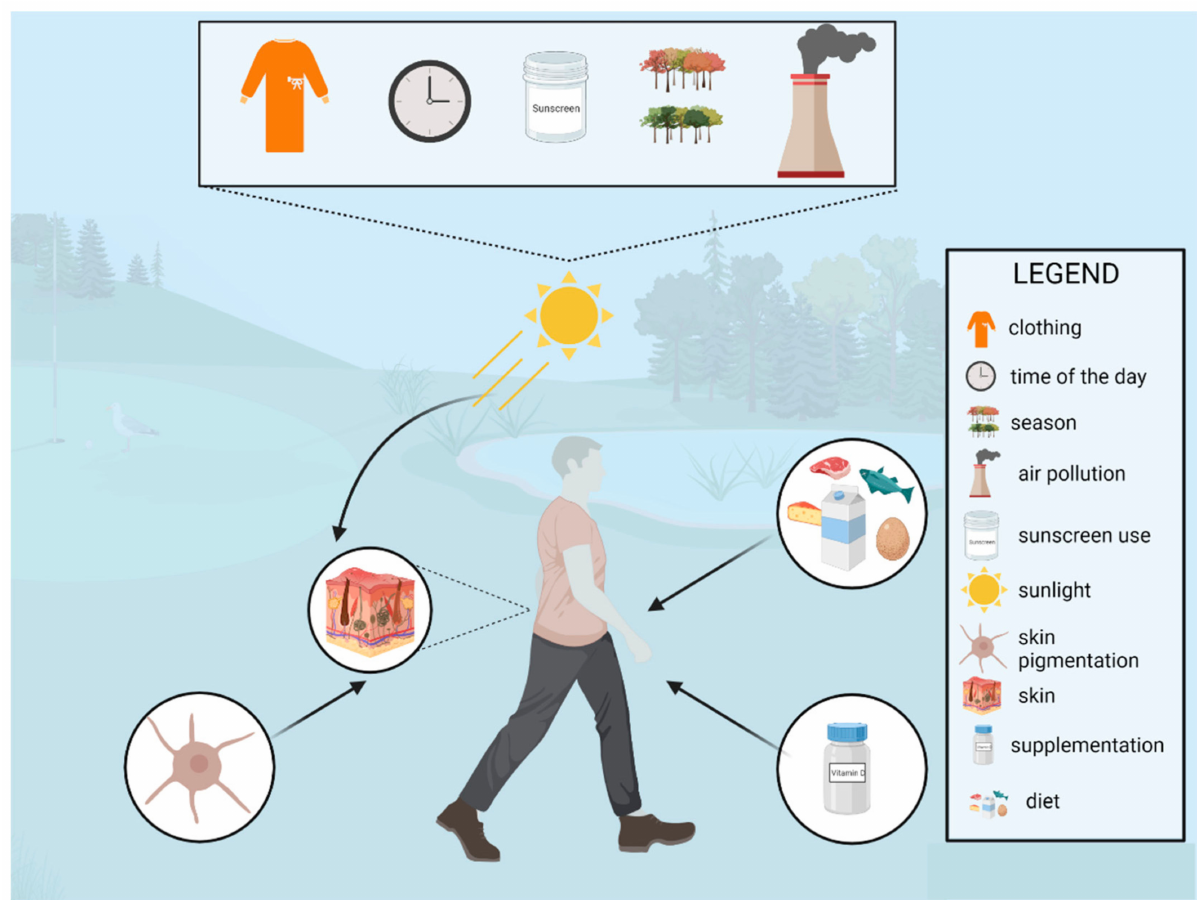
Figure 2. A summary of the potential determinants of vitamin D